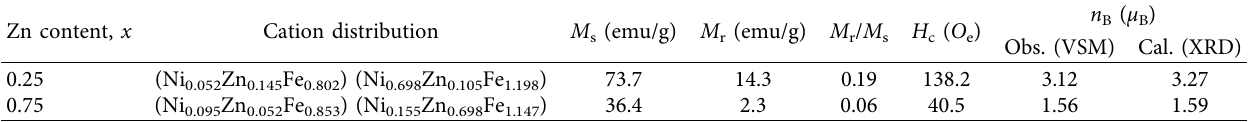
Table 7: The saturation magnetization ( M s ), remanent magnetization ( M r ), loop squareness ( M r / M s ), coercivity ( H c ), and observed